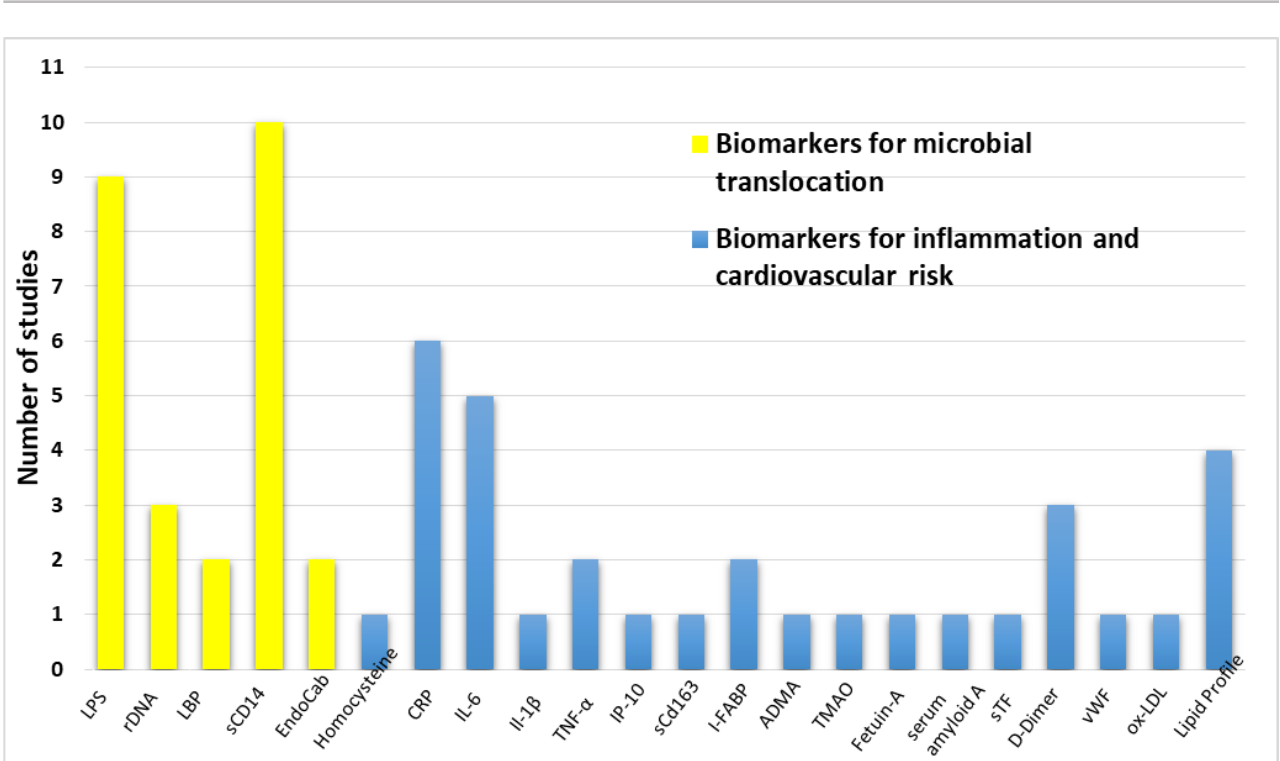
FIGURE 2 - Number of studies evaluating biomarkers of microbial translocation, inflammation and cardiovascular risk. LPS, lipopolysaccharides; rDNA, ribosomal bacterial DNA; LBP, LPS binding protein; sCD14, soluble CD14; EndoCAb, endotoxin nucleus antibody; CRP, C-reactive protein; IL-6, interleukin-6; IL-1 β , interleukin 1 β ; TNF- α , tumor necrosis factor-alpha; IP- 10, interferon- γ -inducible protein 10; sCD163, soluble CD163; I-FABP, intestinal fatty acid binding protein; ADMA, asymmetric dimethylarginine; TMAO, trimethylamine-N-oxide; sTF, soluble tissue factor; vWF, von Willebrand factor; oxLDL, oxidized LDL